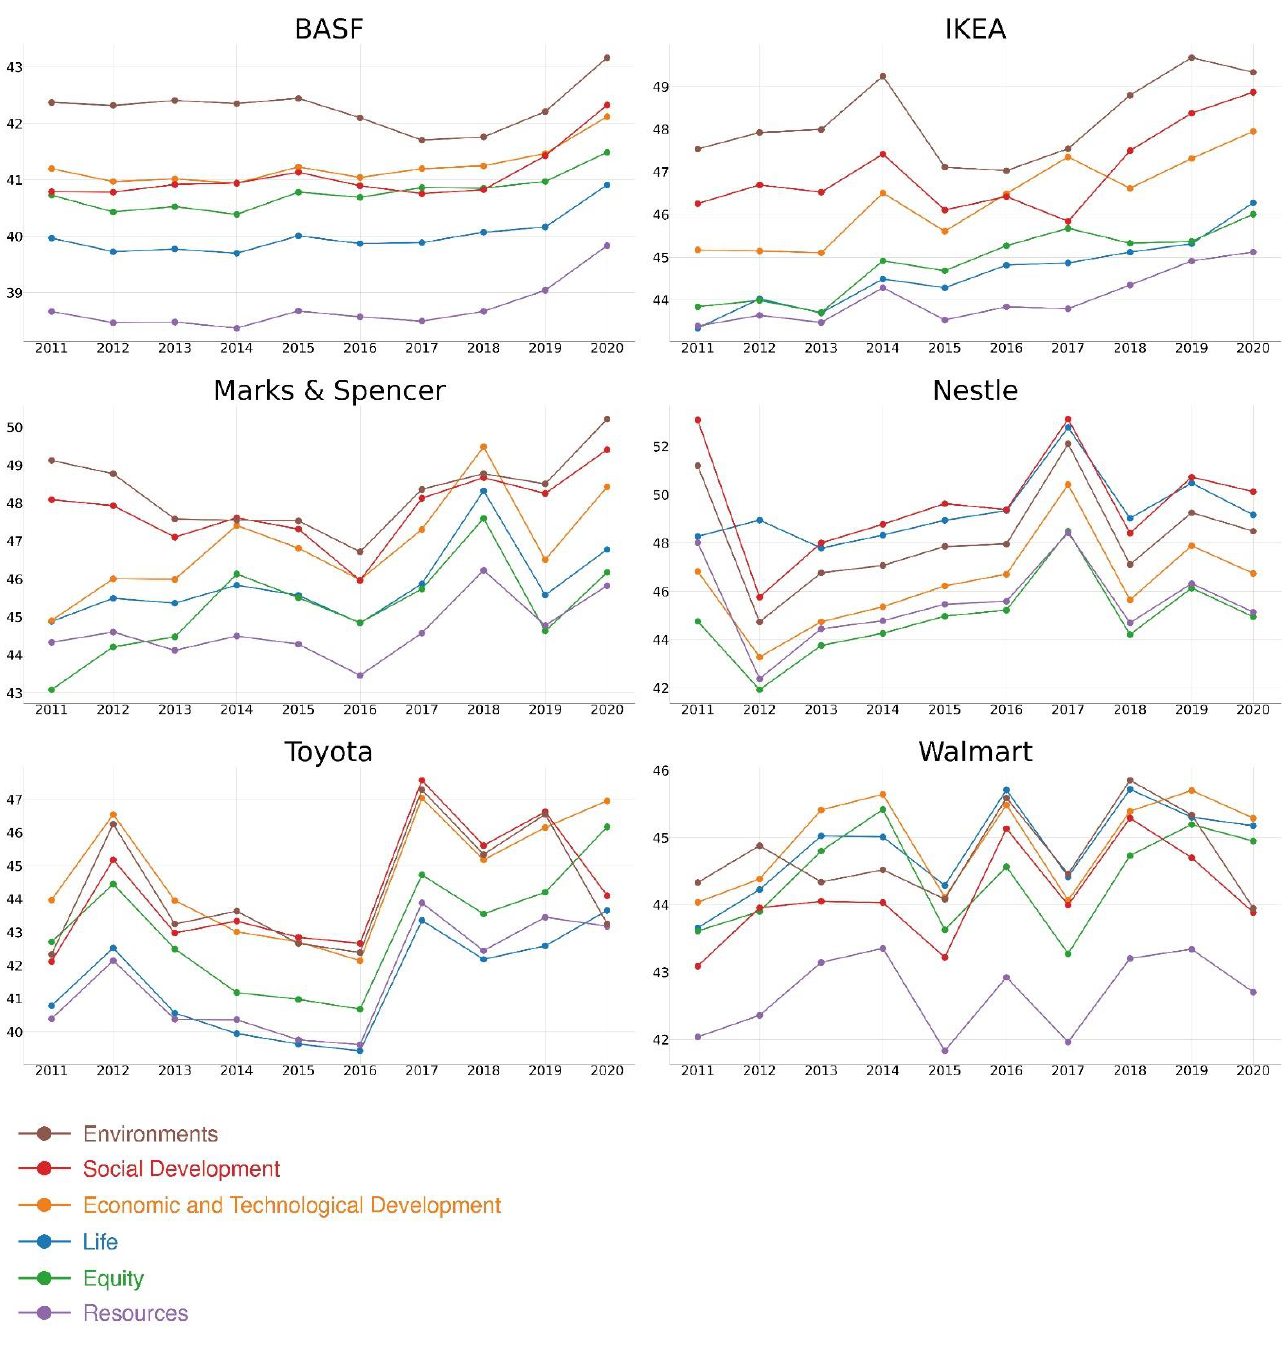
Figure 6. Thematic structure of sustainability reports of 6 companies.